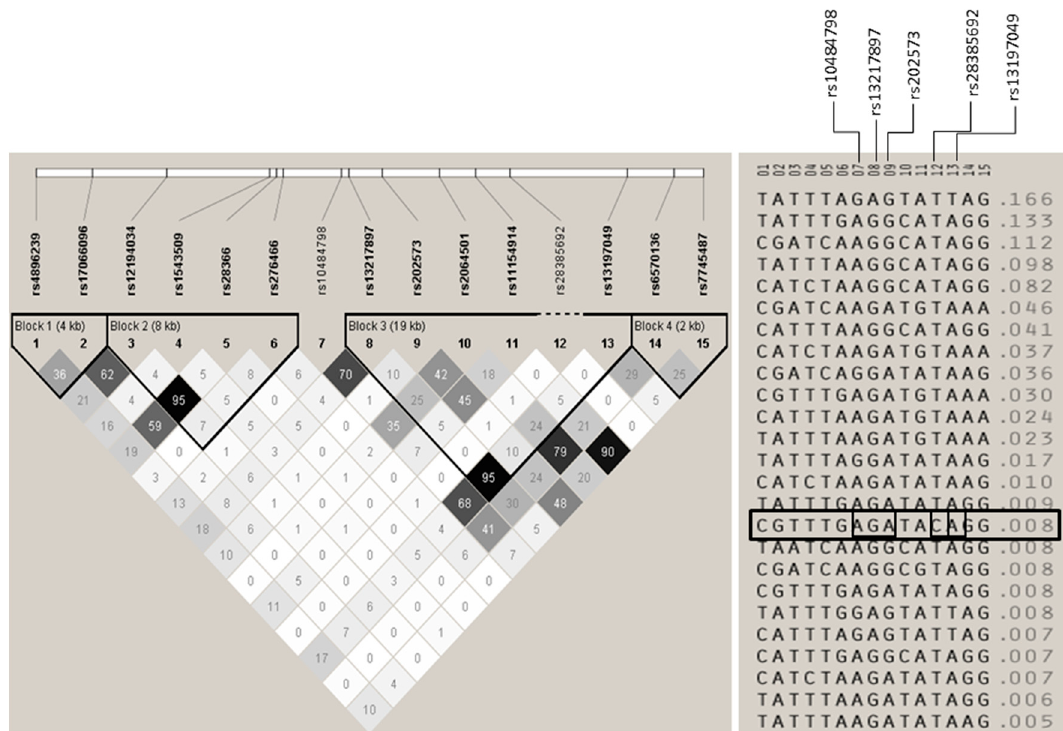
Figure A1. Linkage disequilibrium structure and haplotypes of IL22RA2 . On the left, LD plot of the 15 SNPs analyzed in the Bilbao cohort. Blocks were calculated using the confidence interval algorithm implemented in Haploview [25,26]. Only samples genotyped for all SNPs were considered for the haplotype calculation. The numbers inside the squares indicate r 2 values, and darker shades of gray represent higher degrees of linkage disequilibrium. On the right, all the haplotypes that were present in the Bilbao cohorts considering all SNPs in a single LD block are represented. The only haplotype containing the risk (C) allele of the non-synonymous SNP rs28385692 is boxed. SNPs with significant associations and rs28385692 are indicated on top of the right panel.